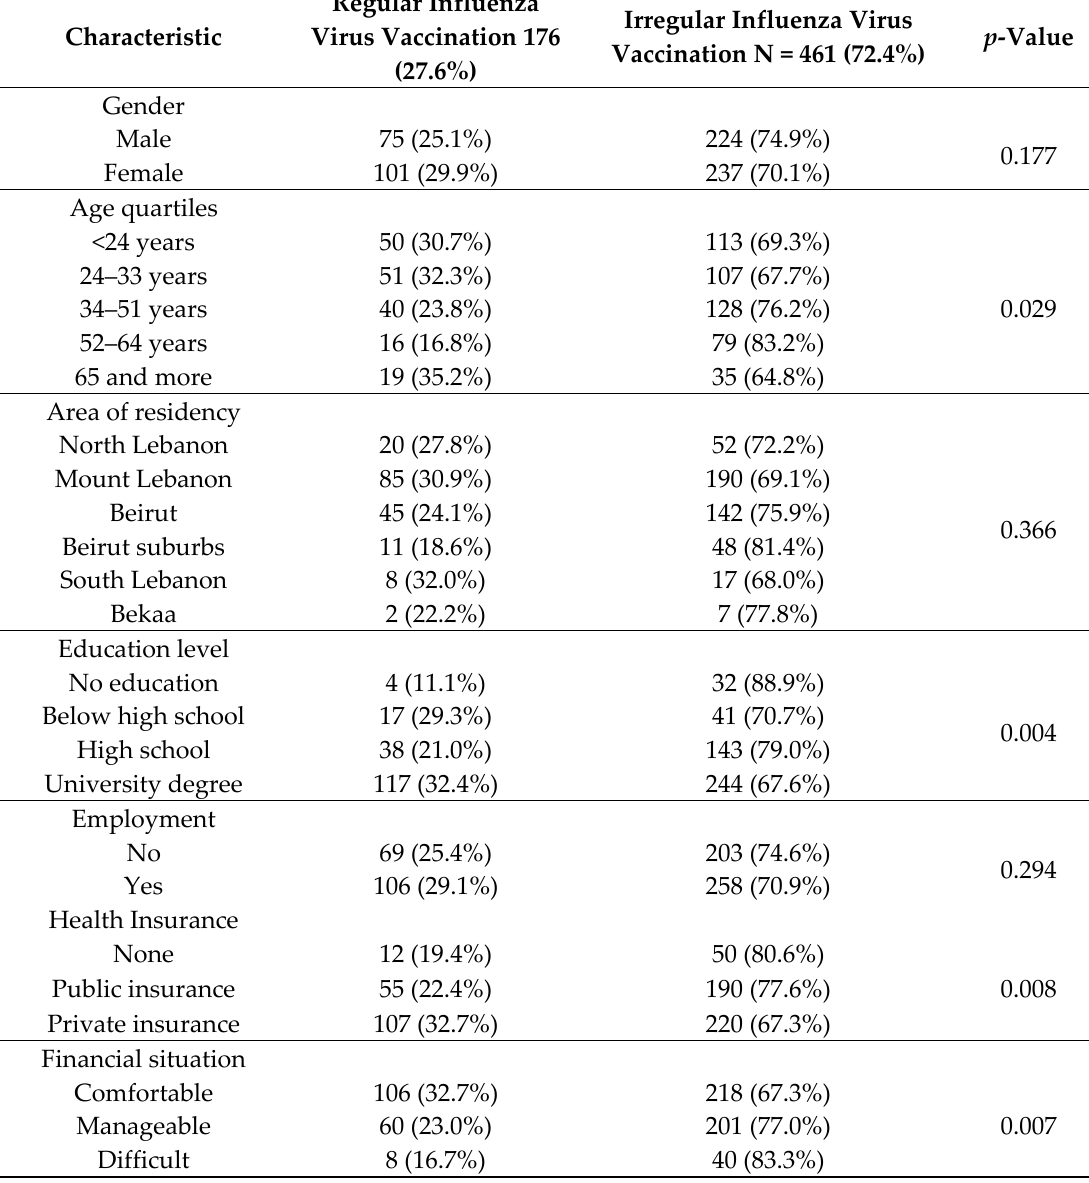
Table 1. Socio-demographic characteristics and regular